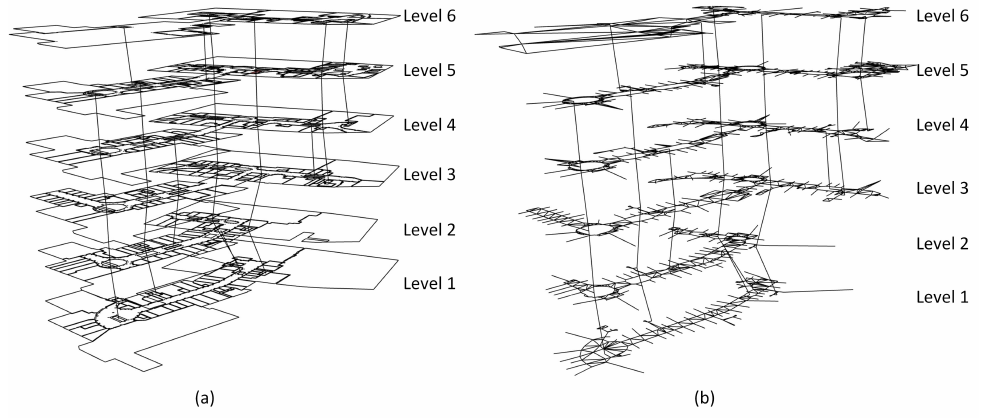
Figure 6. The shopping mall used for tests. ( a ) All the floor plans of the shopping mall, in which the links between different levels are lifts/escalators/stairs. ( b ) The derived navigation networks.